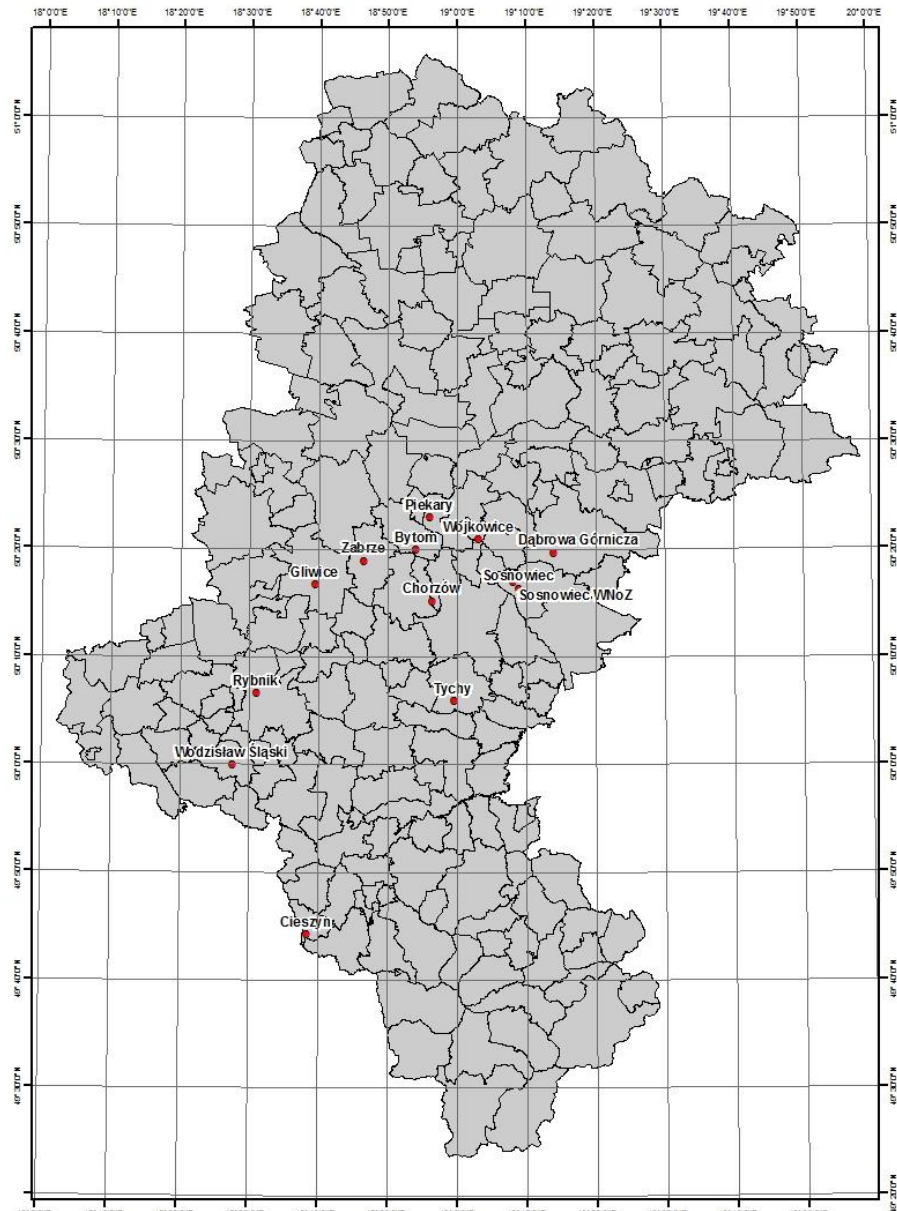
Fig. 1. Location of meteorological stations in the Silesian